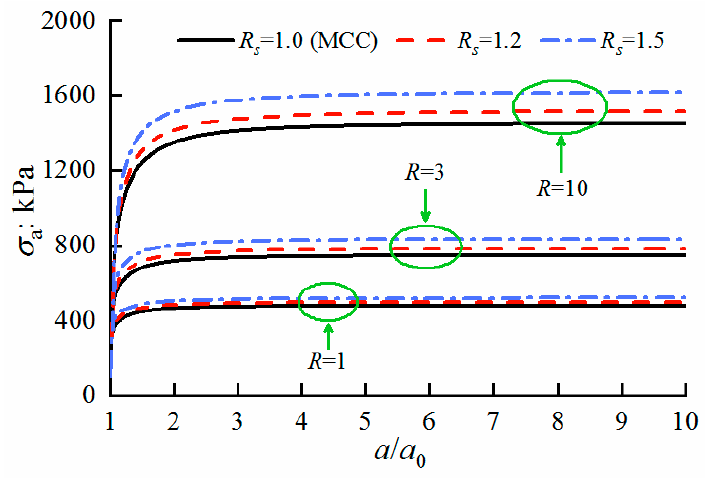
Figure 8. Relationship between the total internal cavity pressure σ a and the cavity radius a/a 0 .